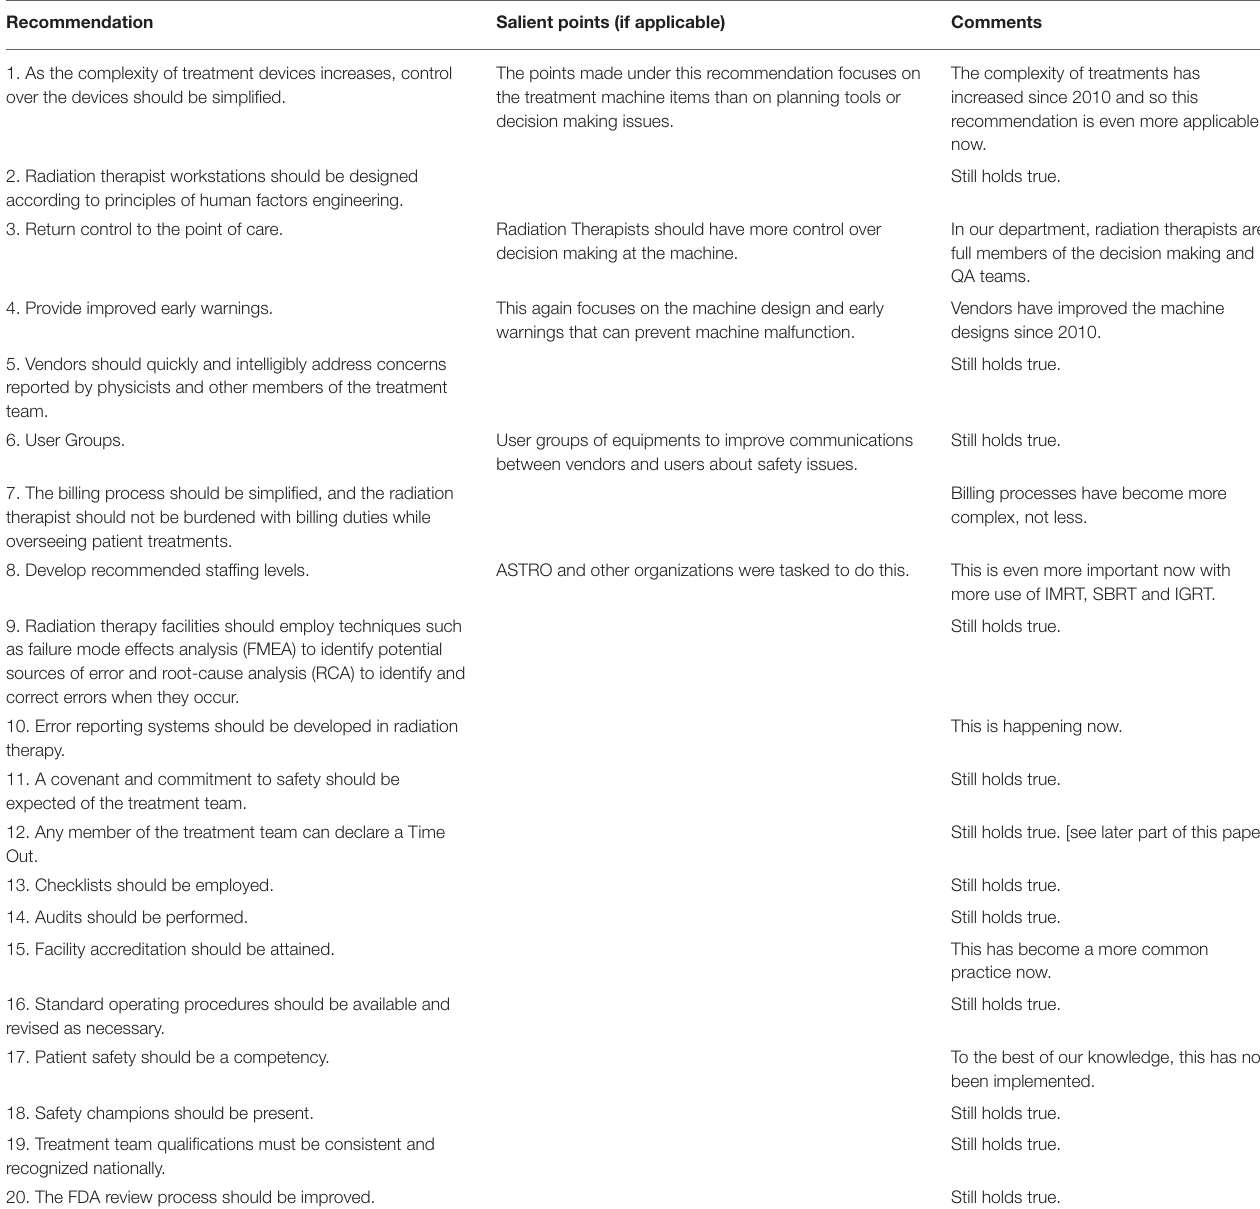
TABLE 4 | Recommendations from “Safety in Radiation Oncology” adapted with comments